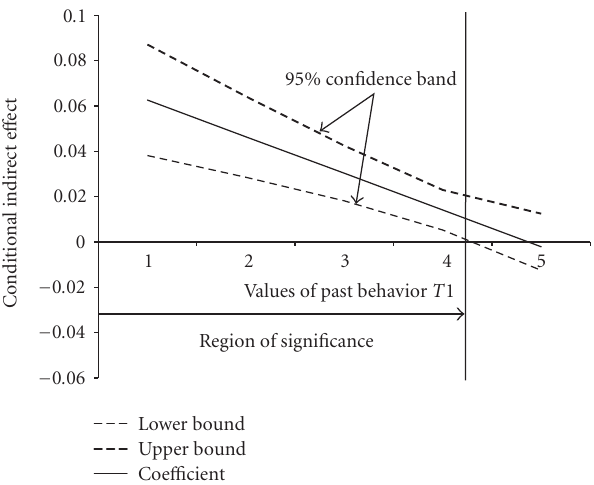
Figure 3: Moderated mediation analysis with Johnson-Neyman technique (risk perception). Note: the horizontal line indicates the lack of an indirect e ff ect (no mediation). The vertical line represents the boundary of the region of significance